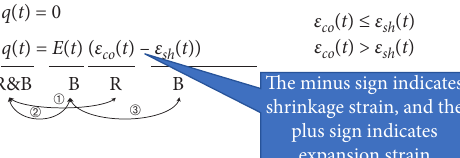
Figure 2: The coupling relationship between backfill stiffness, shrinkage strain, and support force (R is the rock, B is the backfill, ε creep behavior of the nearby rock material, and ε